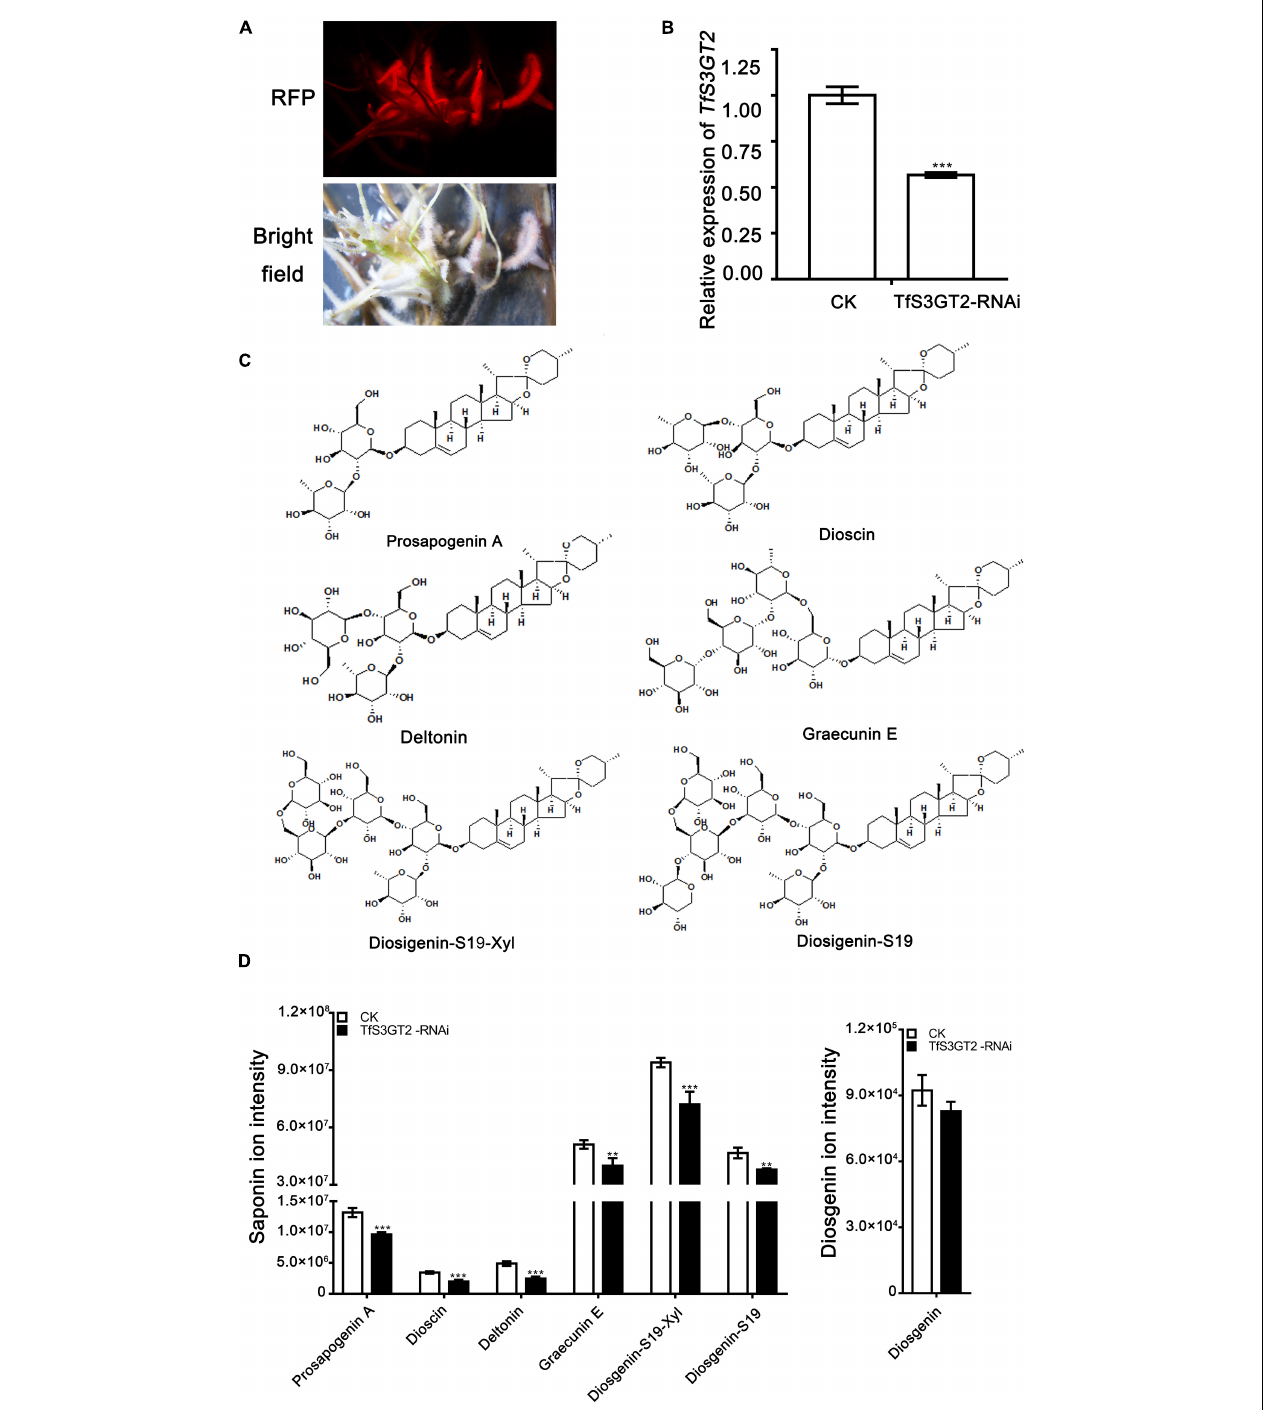
FIGURE 5 | The effects of the RNAi-based silencing of TfS3GT2 on biosyntheses of dioscin, diosgenin, and other targeted steroidal saponins in the transgenic T. foenum-graecum hairy roots. (A) Red fluorescence signal is shown for the presence of the TfS3GT2-RNAi construct in the hairy roots. Scale bar = 1 cm. (B) Real-time PCR analysis of the TfS3GT2 transcript in the TfS3GT2-RNAi compared with the corresponding vector control lines. (C) Chemical structures of the steroidal saponins for the targeted analysis of the transgenic hairy roots. (D) The LC-MS product ion-intensities of the targeted steroidal saponins and diosgenin extracted from the transgenic hairy roots. The data are expressed as the mean ± SD of three biological replicates. Asterisk indicates a significant difference by one-way ANOVA analysis, and significant difference is indicated by ** when P < 0.05, and extremely significant difference is shown by *** when P < 0.01. The mass spectra of the targeted steroidal saponins are shown in Supplementary Figure 4